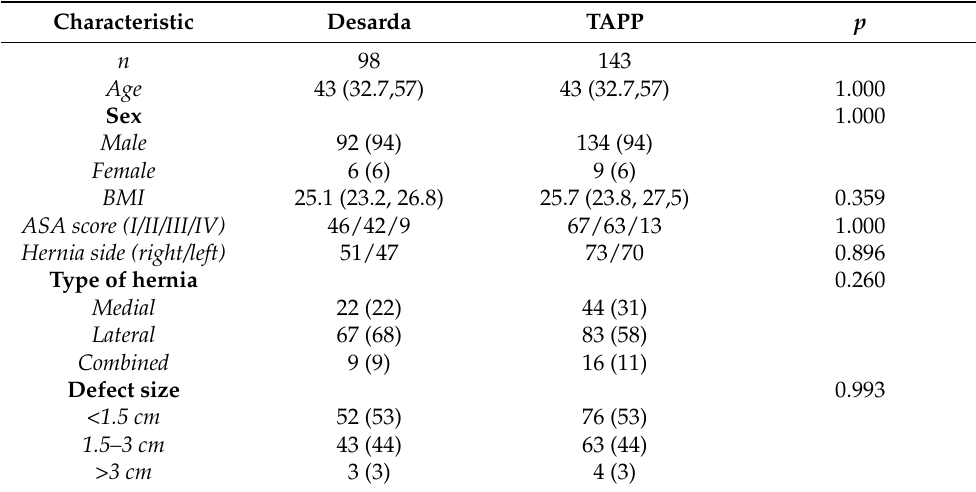
Table 2. Baseline characteristics of matched patient cohorts by operative method. Data are given as n (%) or median (IQR). Chi-square test or Mood’s median test.